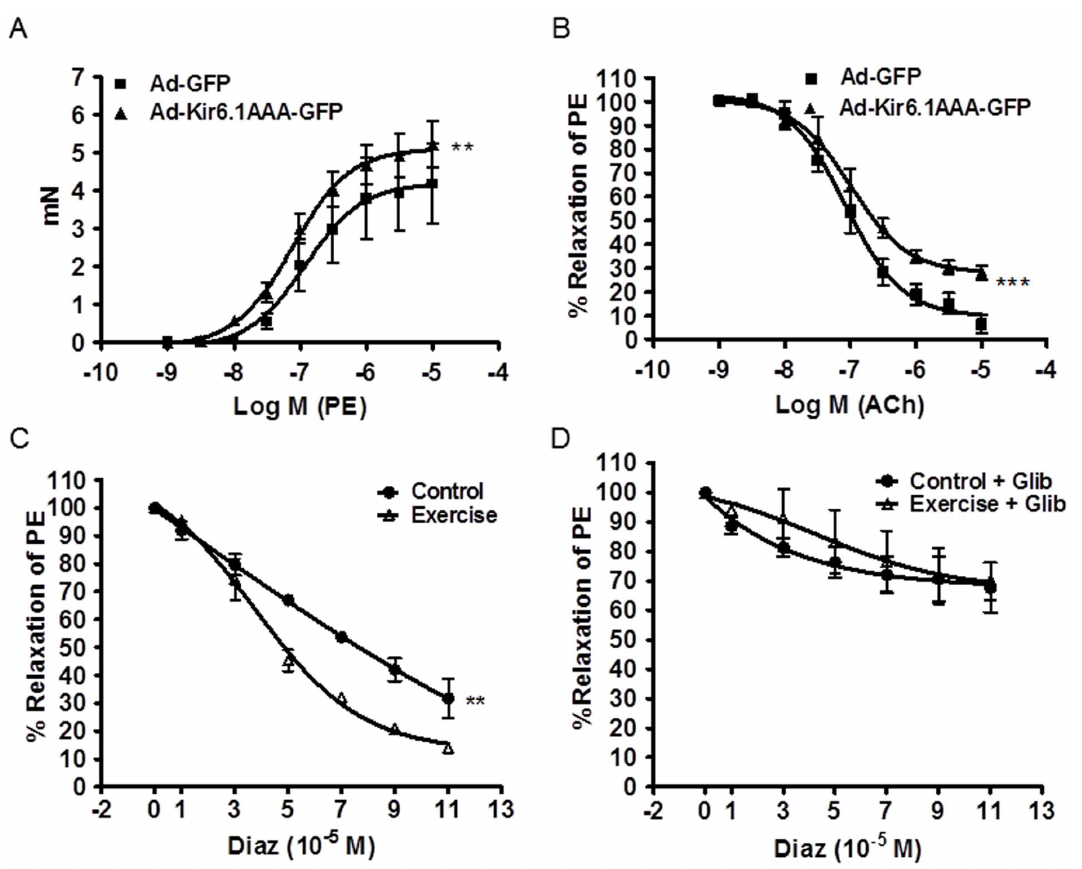
Figure 5. Myography of vasomotor tone in aortic rings. Vasomotor tone changes from control mice transfected with Ad-Kir6.1AAA-GFP and Ad-GFP in response to A: phenylephrine (PE) and B: acetylcholine (ACh); Vasomotor tone changes from the exercised and control mice in response to C: diazoxide (Diaz) and D: glibenclamide pre-treatment and Diaz. **p , 0.01, ***p , 0.001, N 5 5/group.